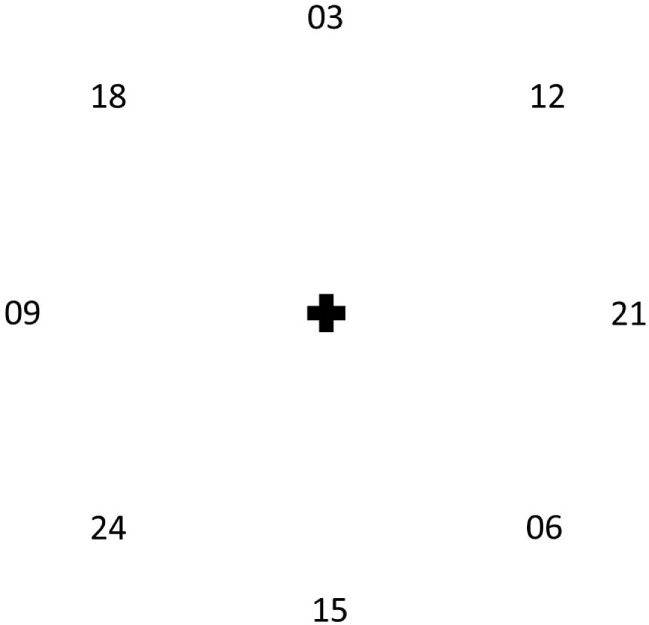
The working surface of the reciprocal trail making task. Participants were asked to start from the cross and move (index finger of the dominant hand) to the numbers in a rising order, returning to the cross after each movement, putting equal emphasis on speed and accuracy.